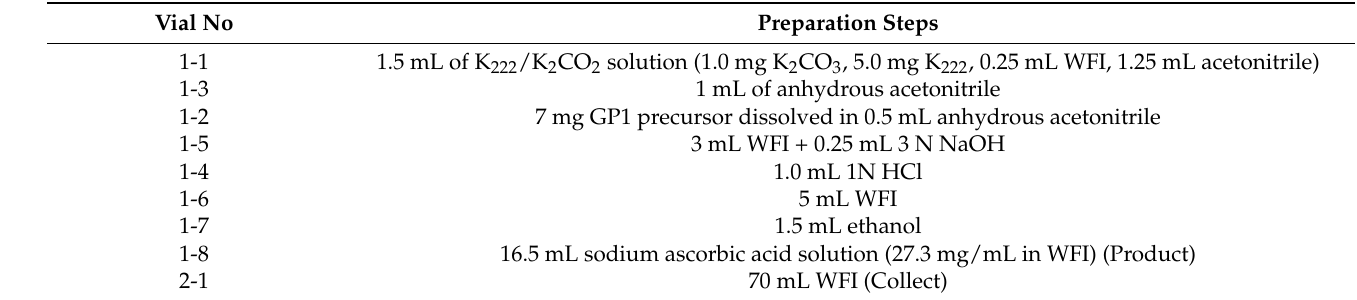
Table 2. Preparation steps and solutions for the synthesis of [ 18